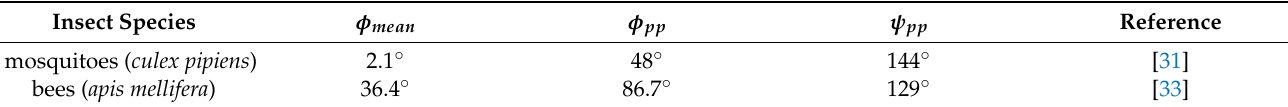
Table 2. Implemented parameters of the wing